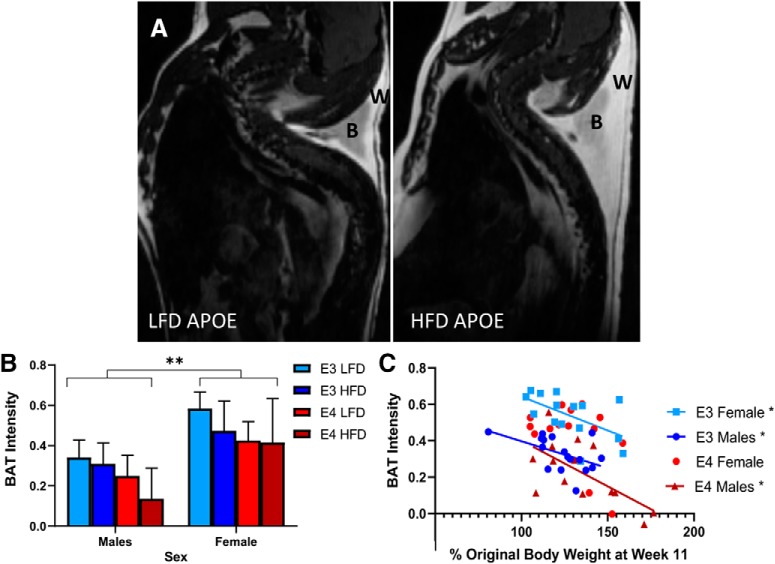
Male APOE mice have decreased BAT. Representative image of BAT in the neck in a LFD mouse and HFD mouse (A). Comparison of BAT intensity in male and female APOE3 and APOE4 mice (B). Correlation of genotype and weight to BAT intensity then sex and weight to BAT intensity lines indicate significant correlations (C). B, BAT; W, WAT; S, spine, TAT, total adipose tissue; B, N = 5–9, **p < 0.004, three-way ANOVA Tukey’s multiple comparison test. C, Linear regression. APOE3 male (N = 17): R
2 = 0.25, p = 0.04; APOE3 female (N = 15): R
2 = 0.32, p = 0.03; APOE4 male (N = 14): R
2 = 0.42, p = 0.01.